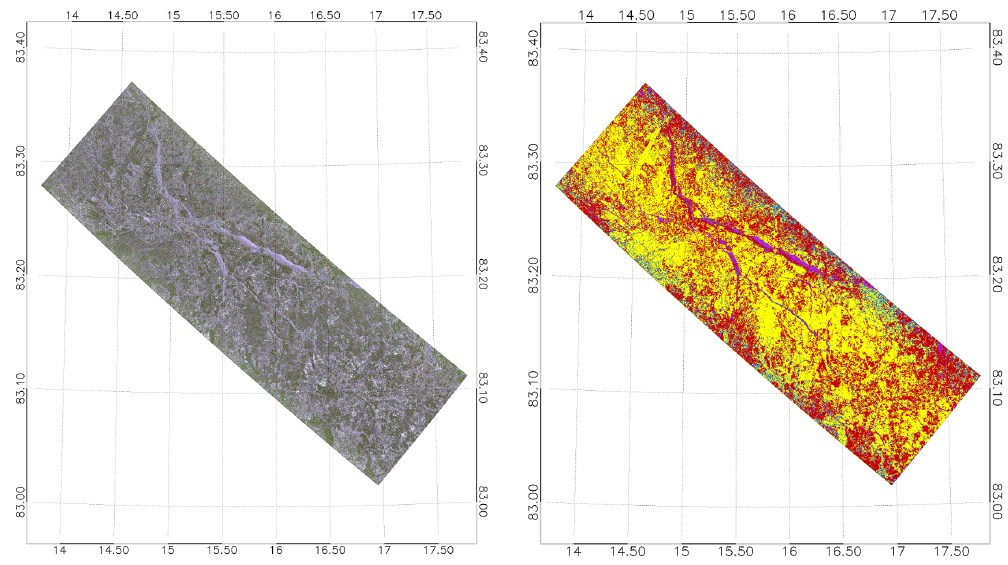
Figure 7. ( Left ) Geocoded Pauli RGB composite (Red: HH-VV Green: HV+VH Blue: HH+VV) of the TS-X acquisition on 23 April 2015, frame 1; ( Right ) ice classification. Blue: open water/nilas (OW), purple: young ice (YI), yellow: first year ice (SFYI), red: rough first year ice/multi-year ice (RFYMYI).